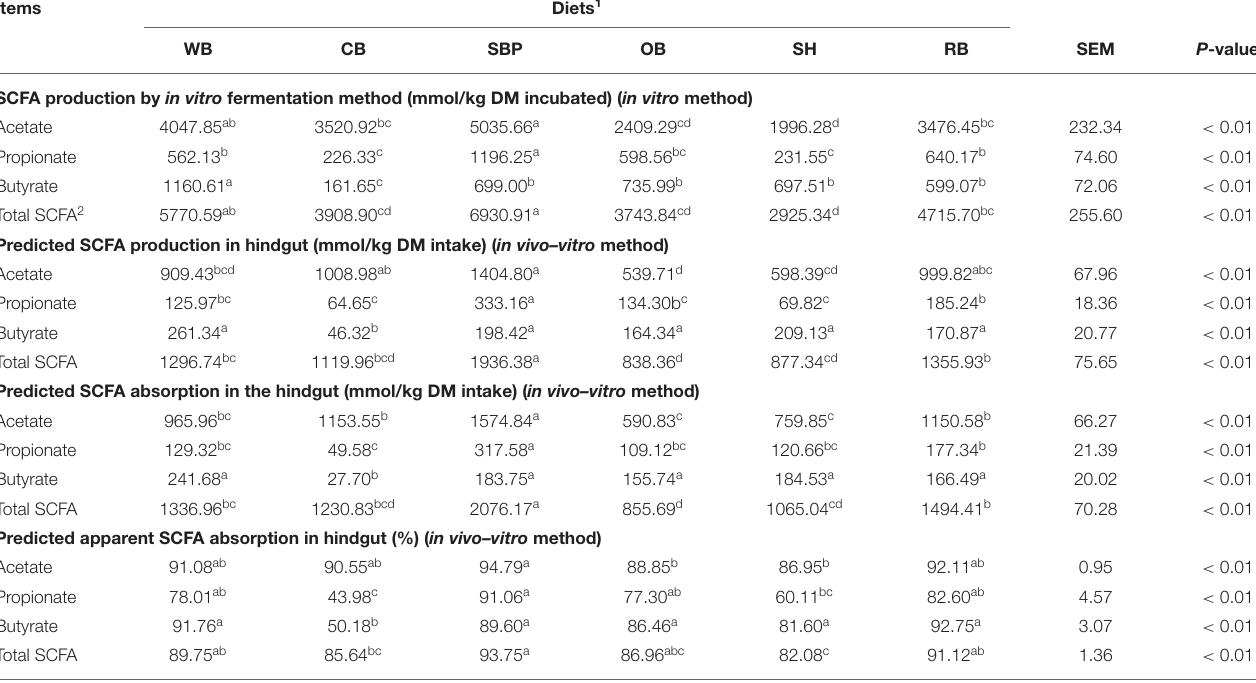
TABLE 3 | Predicted SCFA production and absorption in hindgut ( in vivo–vitro assay) of pigs fed the diets with different sources of fiber ( n = 6 per group). Items